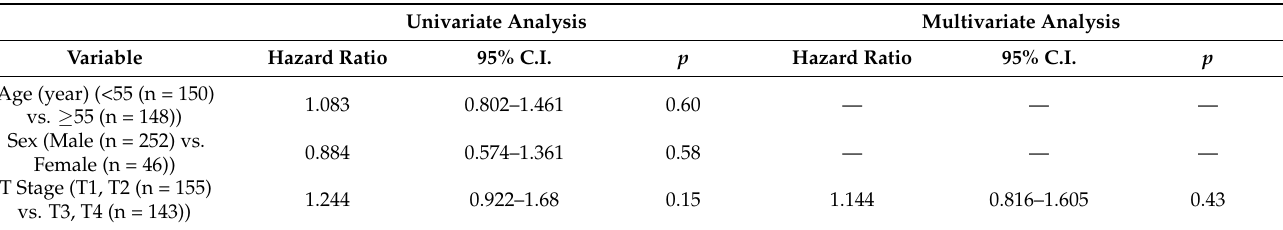
Table 2. Univariate and multivariate analysis of overall survival according to the Cox proportional hazards